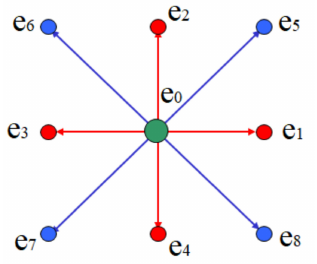
Figure 1. Discrete velocity model